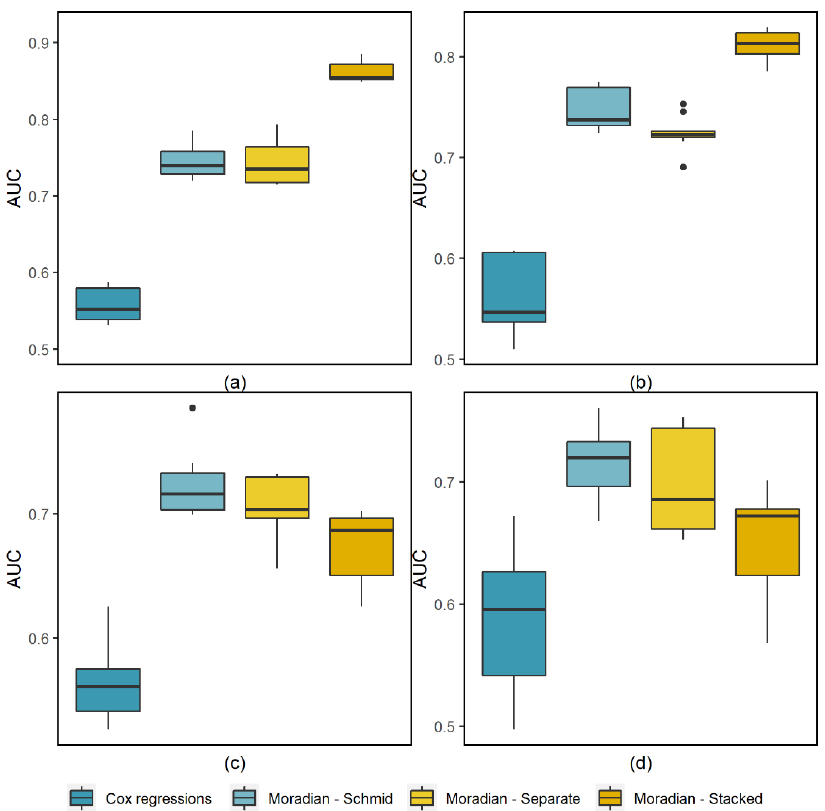
Figure 3. AUC comparison of simulated Cox regressions and random forests (N = 500) when t = 2: ( a ) AUC comparison for t = 2, u = 3; ( b ) AUC comparison for t = 2, u = 4; ( c ) AUC comparison for t = 2, u = 5; ( d ) AUC comparison for t = 2, u = 6.